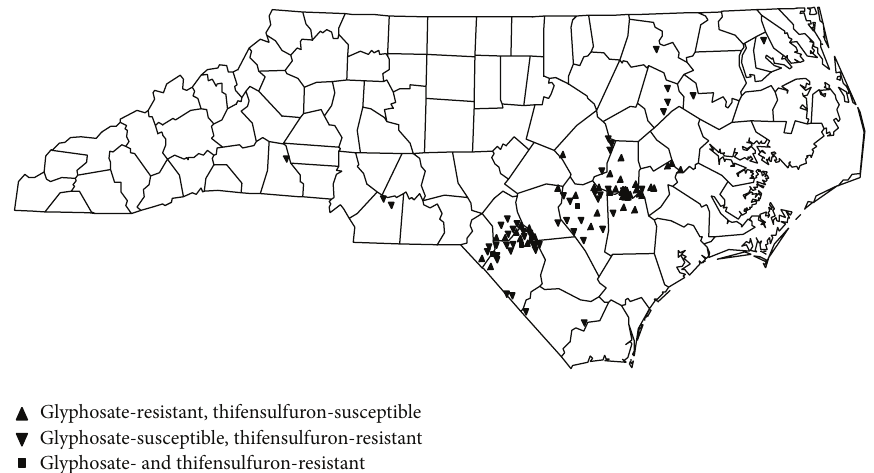
Figure 4: Distribution of glyphosate- and thifensulfuron-resistant Palmer amaranth in 2005, adapted from Whitaker [12].